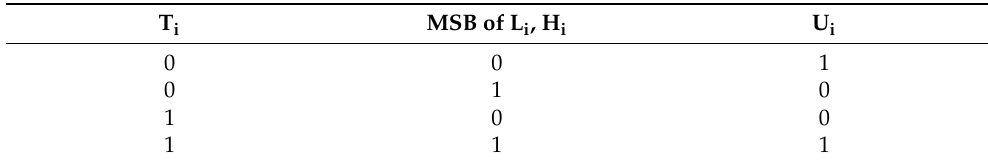
Table 1. Mapping rule of embedding procedure.